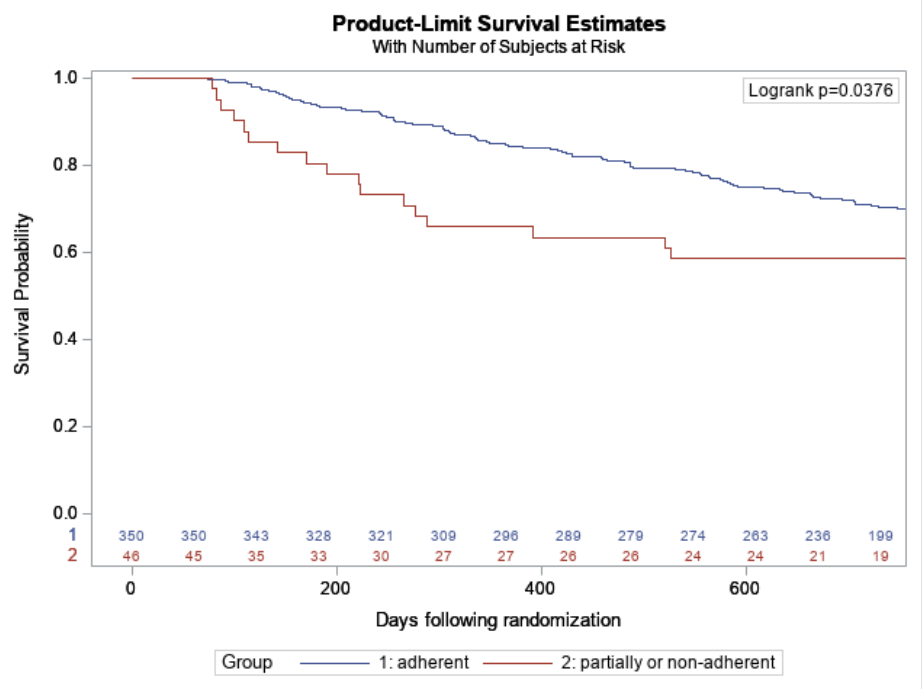
Figure 2. Kaplan–Meier probability of all-cause mortality or heart failure hospitalization in adherent patients vs. partially and non-adherent patients.